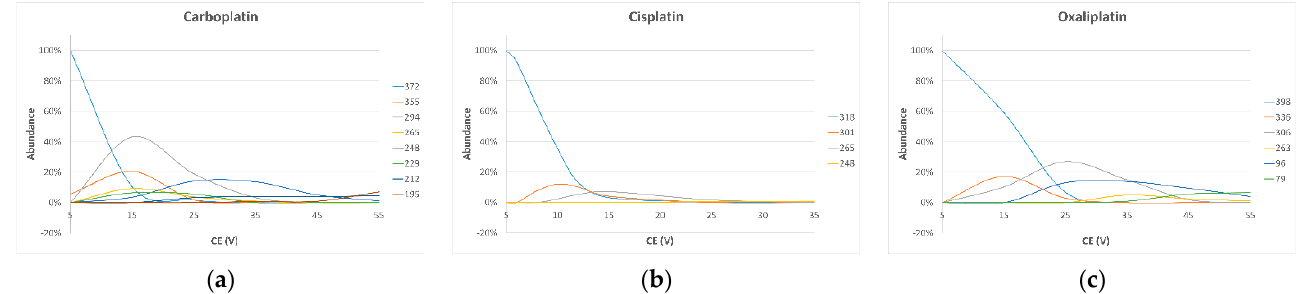
Figure 2. Collision breakdown curves obtained from PIS analysis reporting CE (V) versus percentage abundance. Each panel shows an analyte: ( a ) cisplatin; ( b ) carboplatin; ( c ) oxaliplatin.